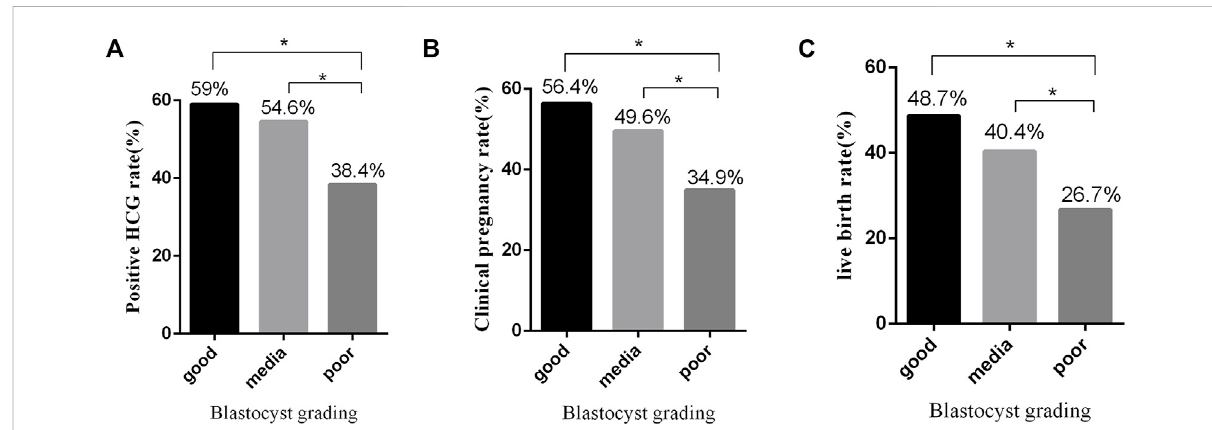
FIGURE 1 Effects of blastocyst grades on clinical outcomes of embryos. (A) Positive hCG rate from FET using embryos with different morphological grades. (B) Clinical pregnancy rate from FET using embryos with different morphological grades. (C) Live birth rate from FET using embryos with different morphological grades. * p ≤ 0.05 (chi-squared